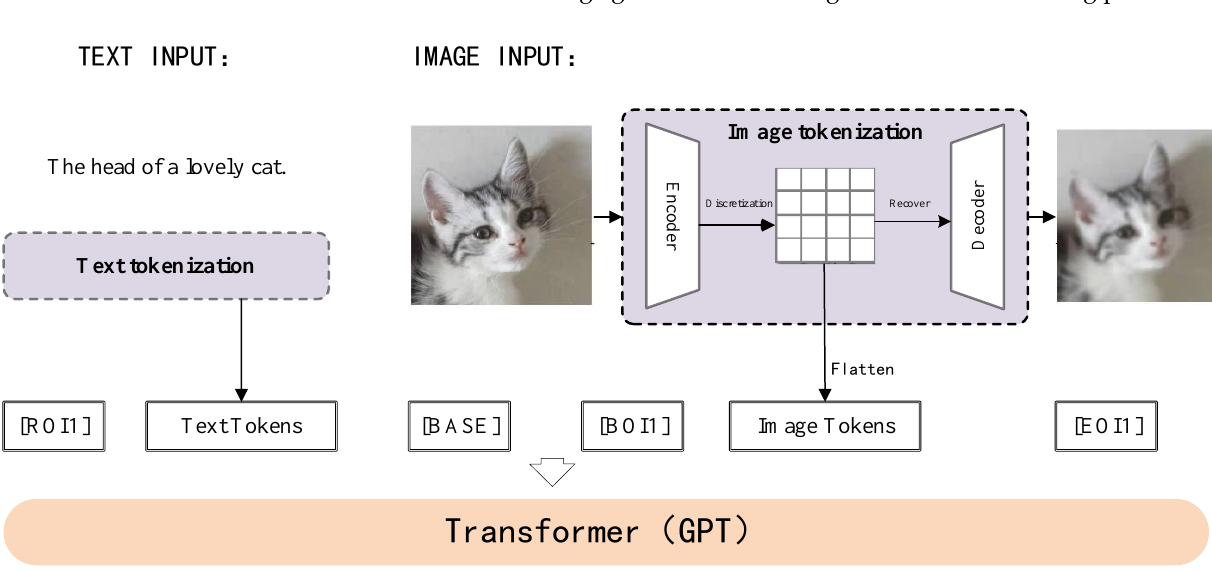
Figure 7. Overview of CogView training architecture.